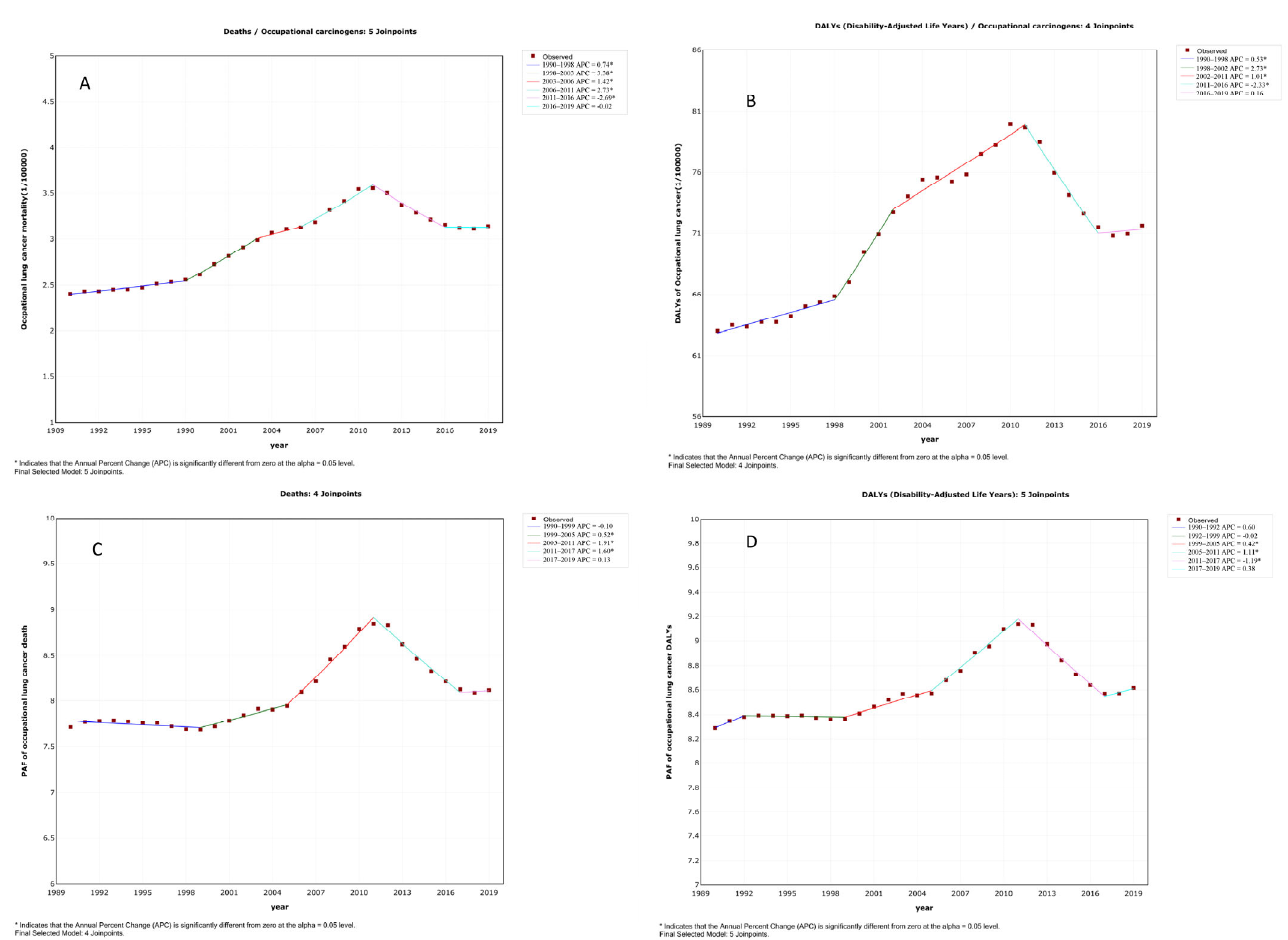
Figure 1. Joinpoint regression analysis of ASMR, ASDR, age ‐ standardized PAF of death rates and DALYs due to lung cancer that could be attributed to occupational carcinogens, recorded from 1990 to 2019, described by the slope of the graph as the annual percentage change for each time segment. ( A ) ASMR with 6 time segments (5 joinpoints). ( B ) ASDR with 5 time segments (4 joinpoints). ( C ) Age ‐ standardized PAF of lung cancer deaths that can be attributed to occupational